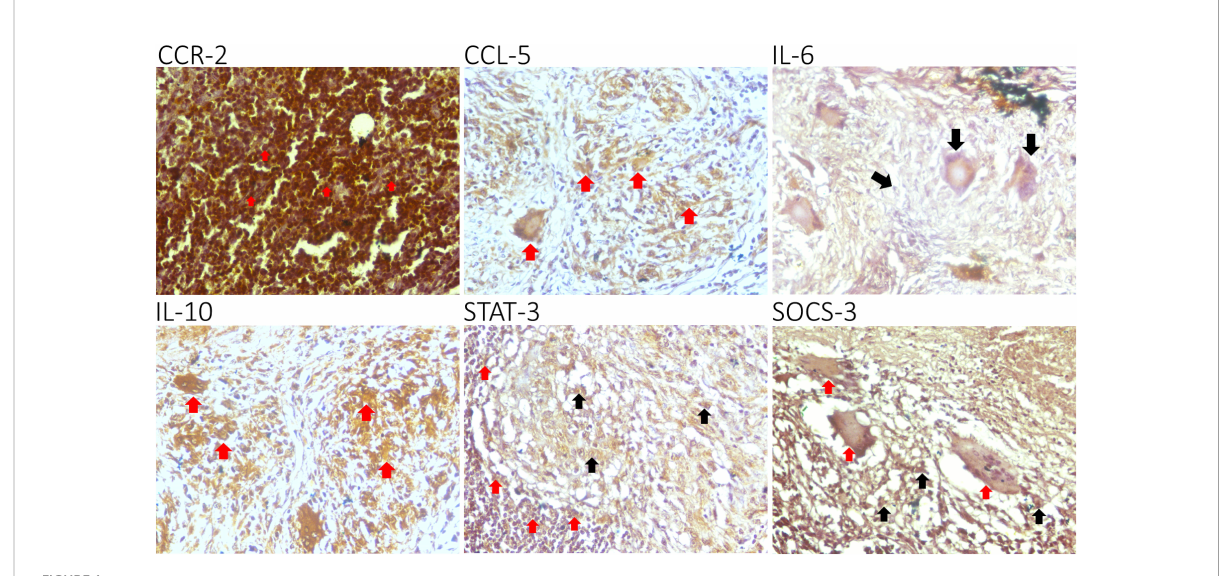
FIGURE 1 Epression of C-C chemokine receptor-2 (CCR-2), C-C chemokine ligand-5 (CCL-5), interleukin (IL)-6, IL-10, STAT-3, and SOCS-3 in lymphocytes (red arrow). A representative biopsy specimen of tuberculous lymphadenitis patient: CCR-2, CCL-5, IL-6, IL-10, STAT-3, and SOCS-3 are expressed in the cytoplasmic areaa. CCR-2 and IL-6 are strongly expressed in the tubercle, while the other markers, especially STAT-3 and SOCS-3, are expressed weakly. GIant cells (group of mature lymphocytes) could also express STATS-3 and SOCS-3 (black